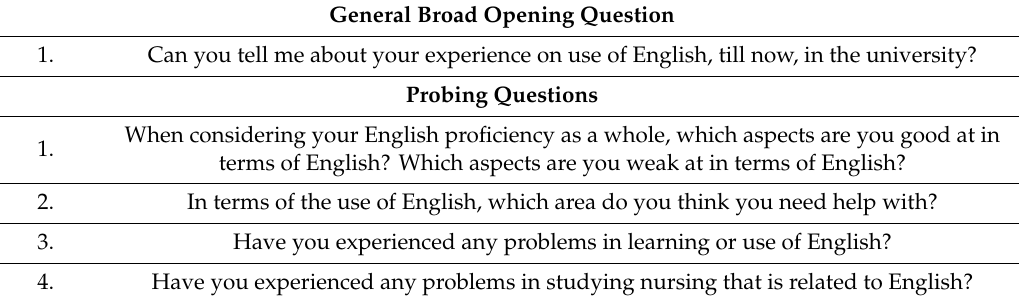
Table 1. Interview guide for exploring the perceived needs and challenges of the English use of college transfer